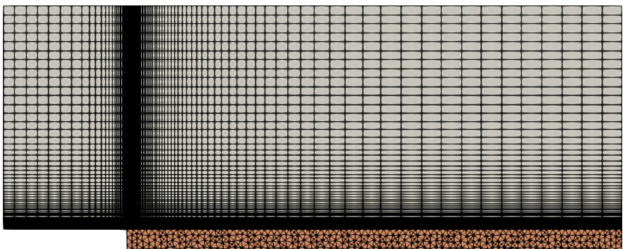
Figure 8. Fluid and solid meshes for the conjugate problem applied to a flat plate. Table 1. Flat plate domain characteristics and boundary conditions.